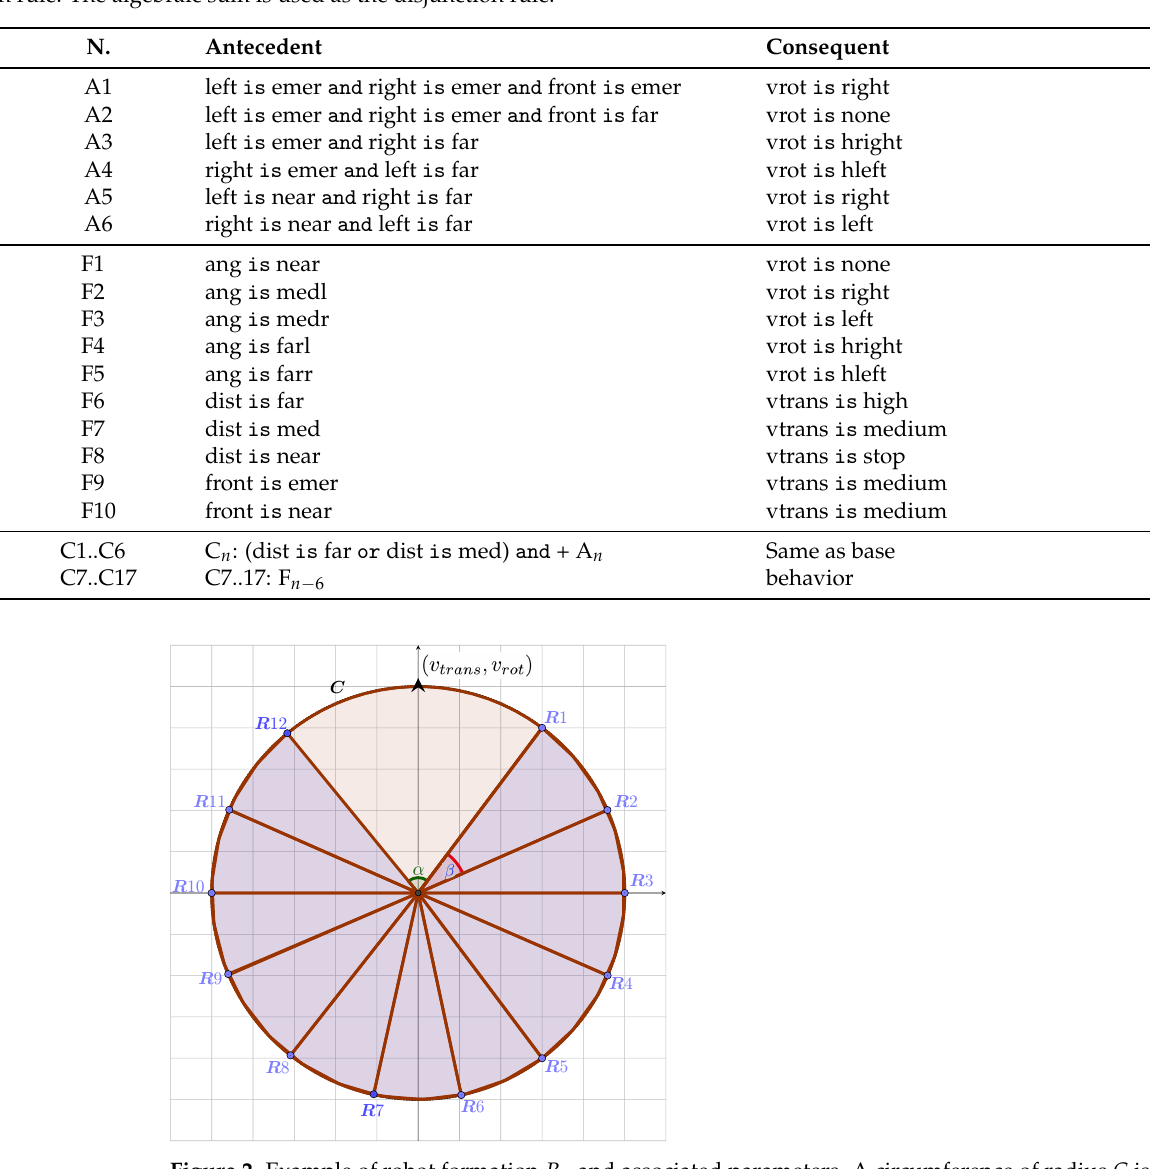
Figure 2. Example of robot formation R n and associated parameters. A circumference of radius C is shown, on which 12 robots are placed. The α angle limits the area not occupied by robots to generate the U-shaped formation. The β angle is obtained such that β = 2 π − α and is the same between n correlative pairs of R . The macroscopic formation can be moved and rotated with translational and rotational speed. This formation can also vary the radius C . The diffuse microscopic behaviors are used to calculate the local forces to be applied to each robot to achieve this final